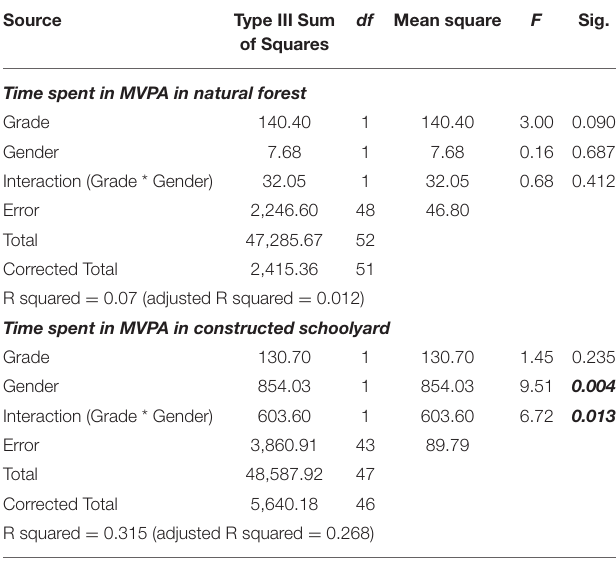
TABLE 2 | Time spent in MVPA in the natural forest and constructed schoolyard across grade and gender: a two-way analysis of variance.